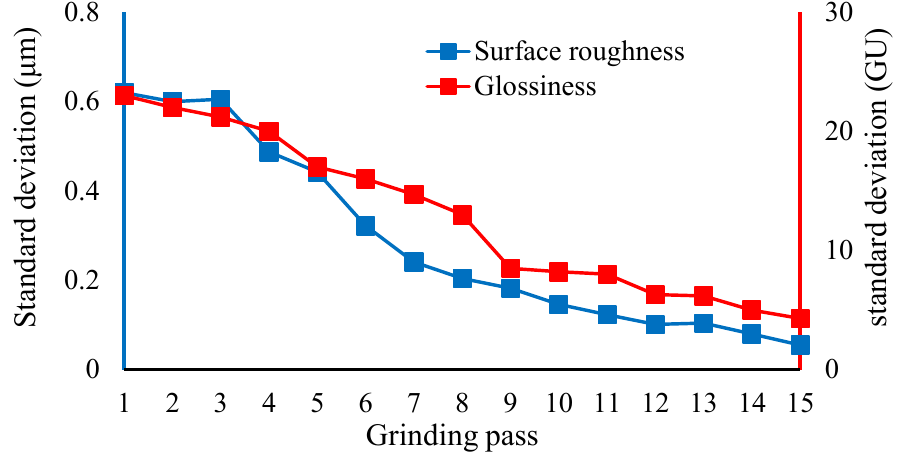
Figure 16. The standard deviations of surface roughness and glossiness of measuring points.